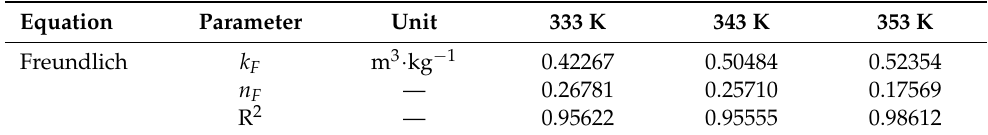
Table A9. Adsorption isotherm parameters for Ru(cod)(tmhd) 2 from scCO 2 solution on CA22 at 19.3 MPa and different temperatures [63].